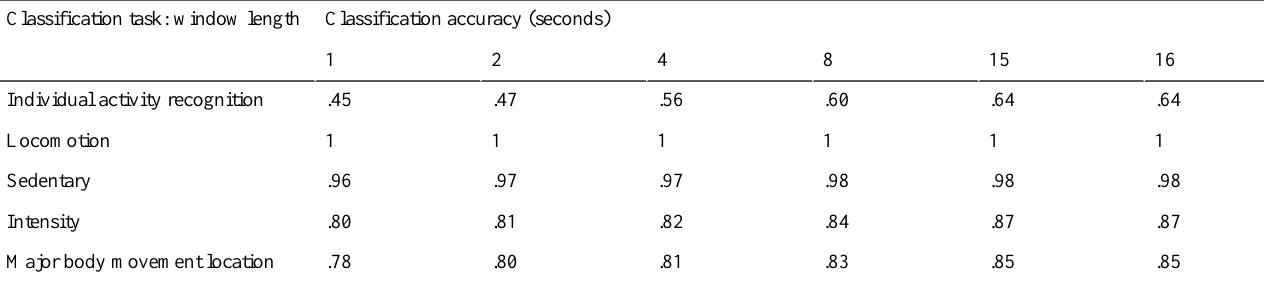
Table 5. Effect of window length for feature extraction on micro-averaged accuracy using random forest model for individual activity recognition, locomotion detection, sedentary activity detection, activity intensity level classification, and major body movement location detection. The best performance for each classification task is presented in